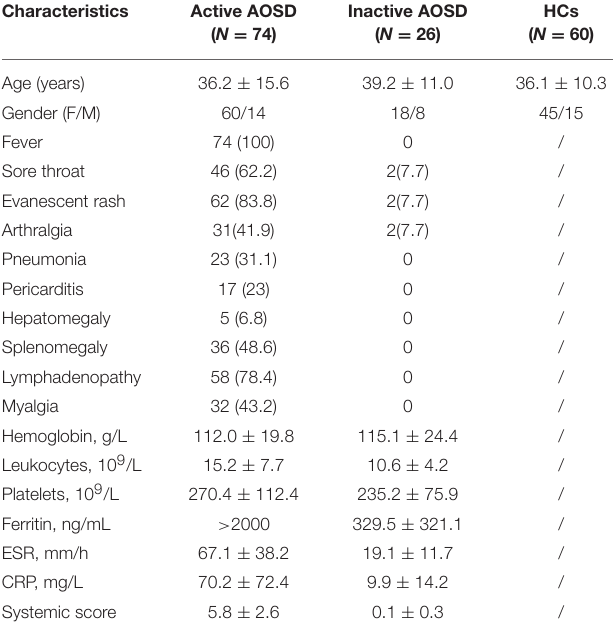
TABLE 1 | Demographic and clinical characteristics of individuals with AOSD.